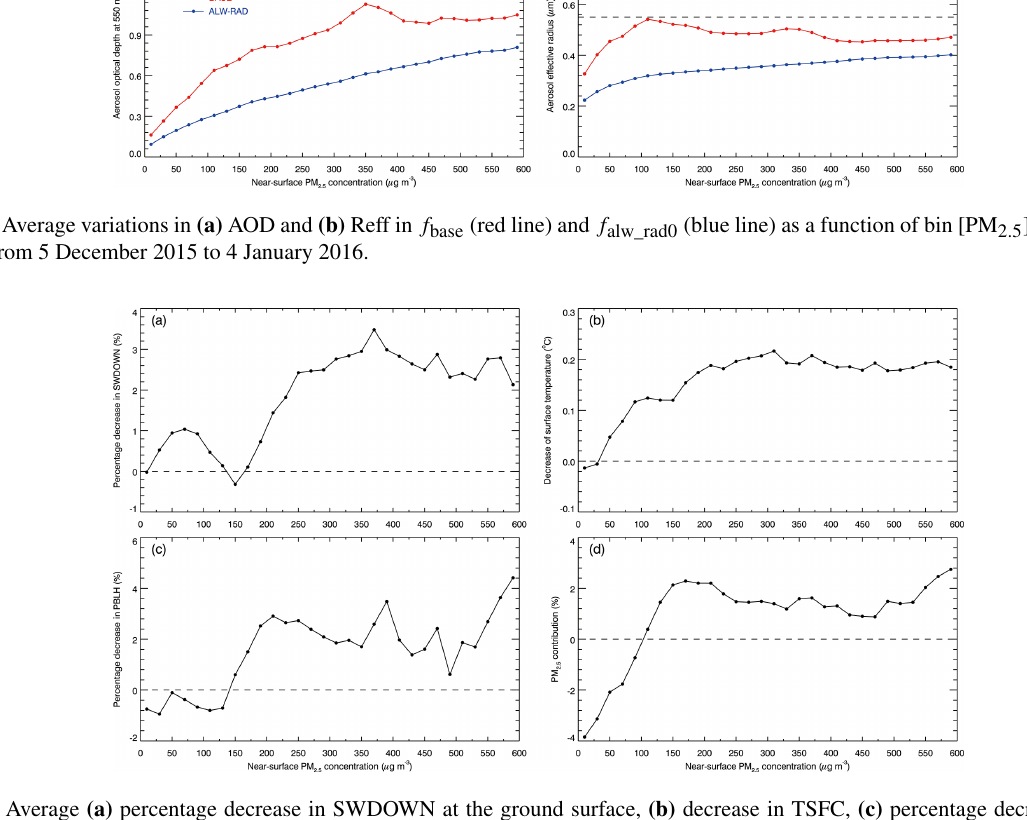
Figure 8. Average (a) percentage decrease in SWDOWN at the ground surface, (b) decrease in TSFC, (c) percentage decrease in PBLH, and (d) percentage contribution of near-surface [PM 2 . 5 ] caused by the ALW-ARF as a function of the near-surface [PM 2 . 5 ] in NCP during daytime from 5 December 2015 to 4 January